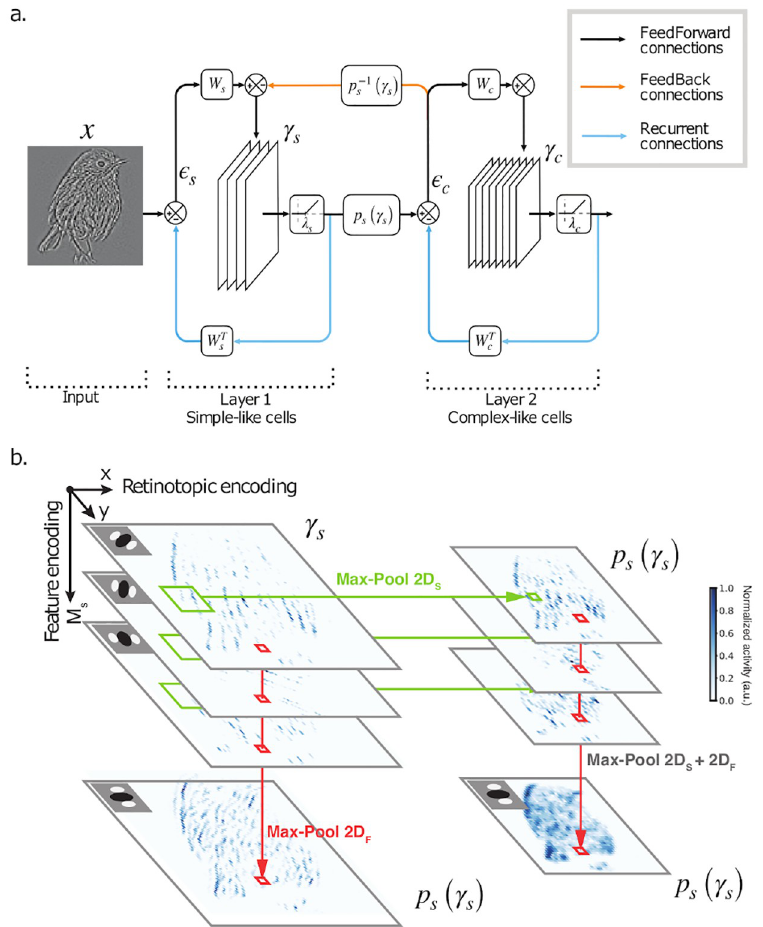
Fig 1. The SDPC network. a . Update scheme of the SDPC network used in this study: x is the input image, γ represent simple and complex cells response maps, respectively. W s and W c are convolutional kernels that encode for the RFs of the simple and complex cell layers, where each synaptic weight matrix is composed of M s and M c neurons ( γ ) is the pooling function used to generate position and feature invariance in the response of (kernels) respectively. p s s the second layer. Feed-forward connections carry information on the prediction errors ( � s and � c ) that are used to refine the neural activities. Feedback information is carried through the unpooling function p (cid:0) 1 the derivative of the pooling function. The circles with arrows inside are error nodes such that the output signal is equal to the difference of the input signal. b . Here, we show a representation of γ s and p ( γ s ). Each pixel represents a model neuron and the color code indicates the amplitude of the neural response (lighter for no response and darker blue for the maximal response, here normalized to 1). In this figure, we illustrate three possible outputs p generate different network structures: MaxPool 2 D S selects the maximum activity over spatial (retinotopic) positions, in each plane independently; MaxPool 2 D acts in the feature space by selecting the maximum activity across planes in F γ s . When the network integrates the two pooling functions in sequence, we refer to them as a unique max-pooling operator called MaxPool 2 D + 2 D S F